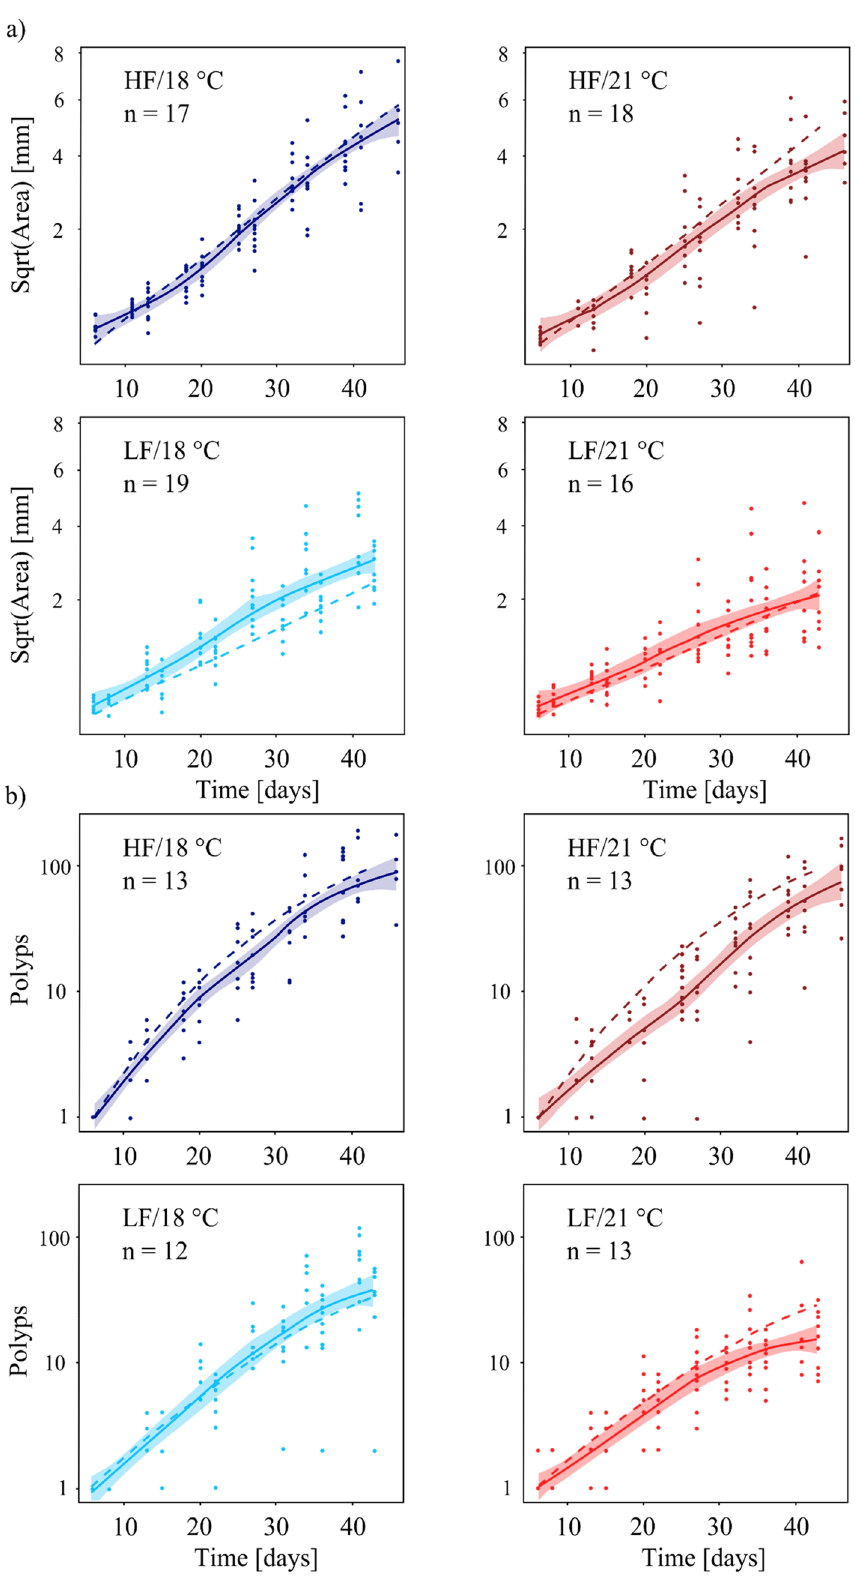
Figure 4. Area ( a ) and polyp number ( b ) of juvenile H. echinata in scenario 1over a period of six weeks post- settlement (median ± SE; solid line and shaded region) compared to numerical growth model data (dashed lines). HF = high food (dark blue and red lines); LF = low food (light blue and red lines); 18 °C = control temperature (blue lines); 21 °C = high temperature (red